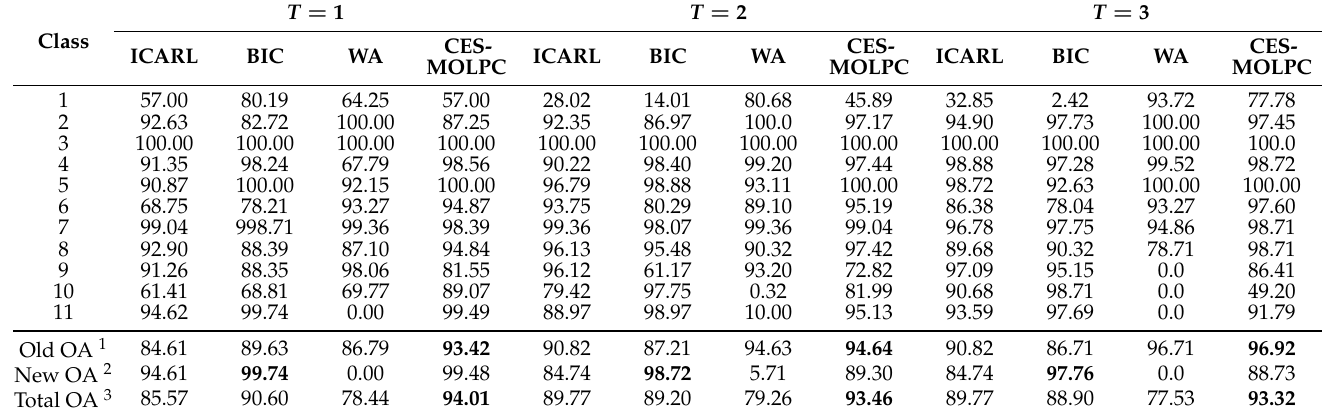
Table 3. Results of experiments on the RML2016.04c data set ( T = 1,2,3).